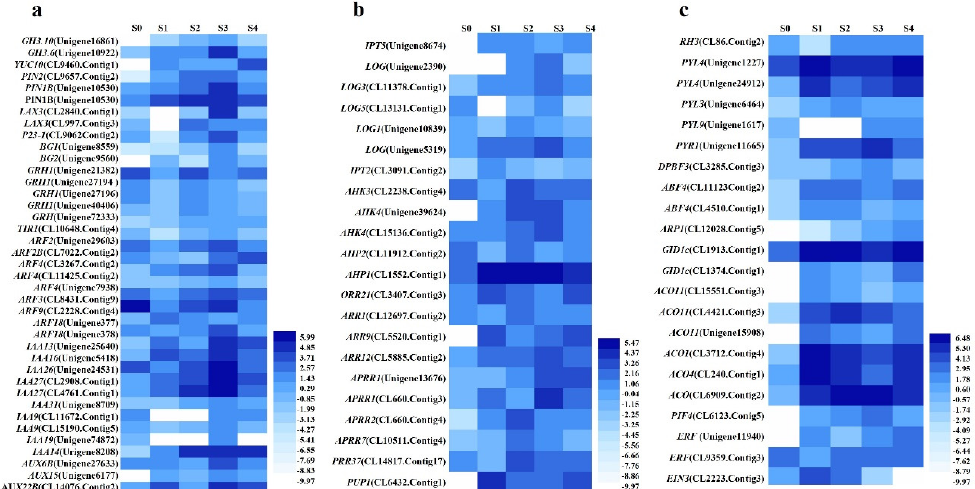
Figure 6. Identification and analysis of the DEGs annotated to the synthesis and signal pathways of hormones. ( a ) Auxin pathway. ( b ) Cytokinin pathway. ( c ) Pathways of other hormones, such as abscisic acid (ABA), gibberellic acid (GA), and ethylene.